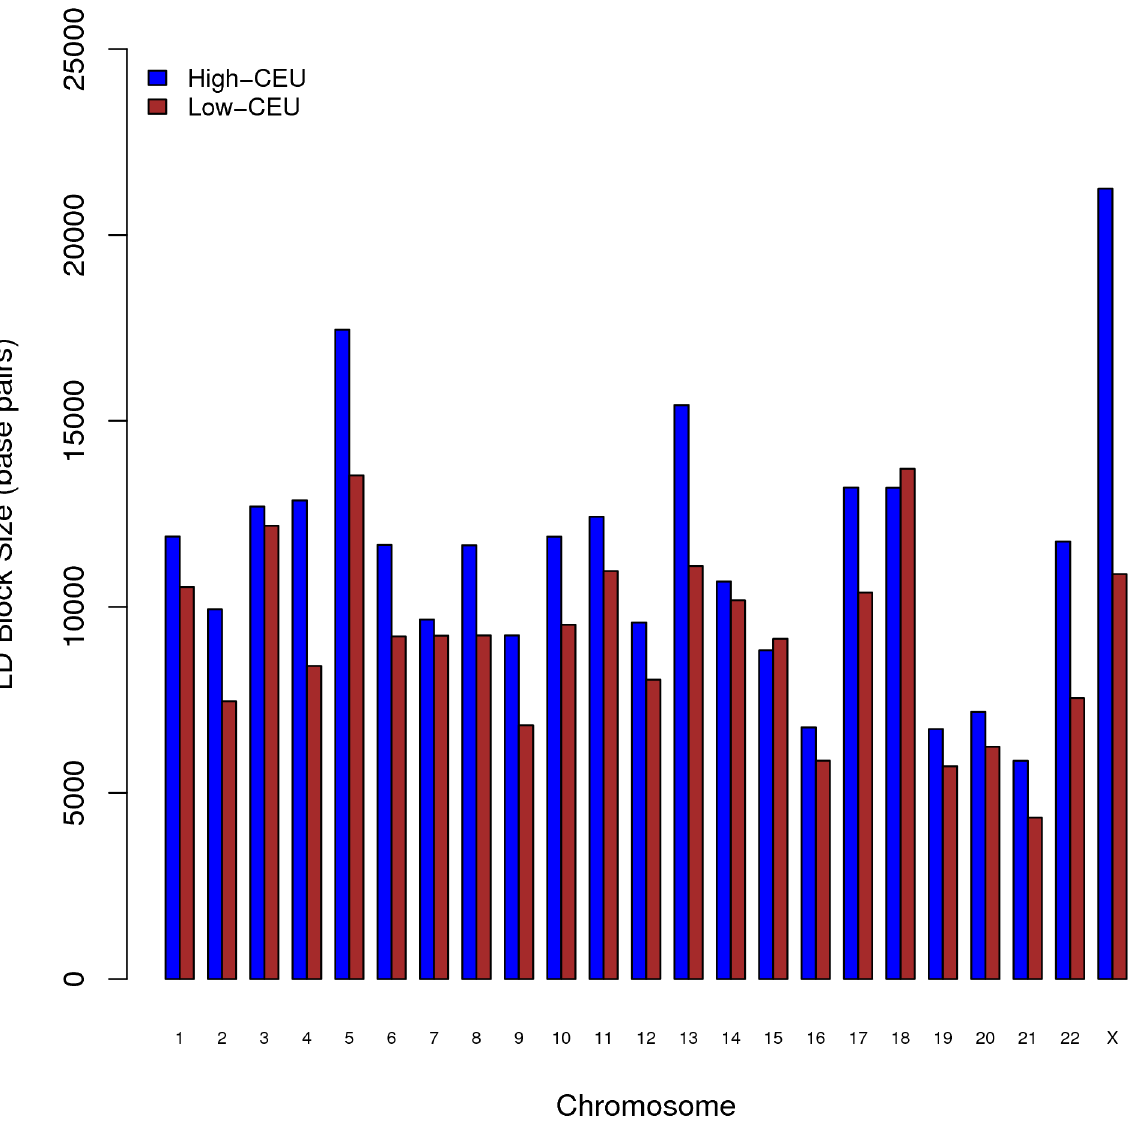
Figure 7. Comparison of the average LD block size for each chromosome between the two subpopulations. LD block size in base pairs for each chromosome was averaged over all LD blocks identified by Haploview 16 . The high-CEU group has average block sizes that were larger than those observed for the low-CEU group for all chromosomes except chromosomes 15 and 18.